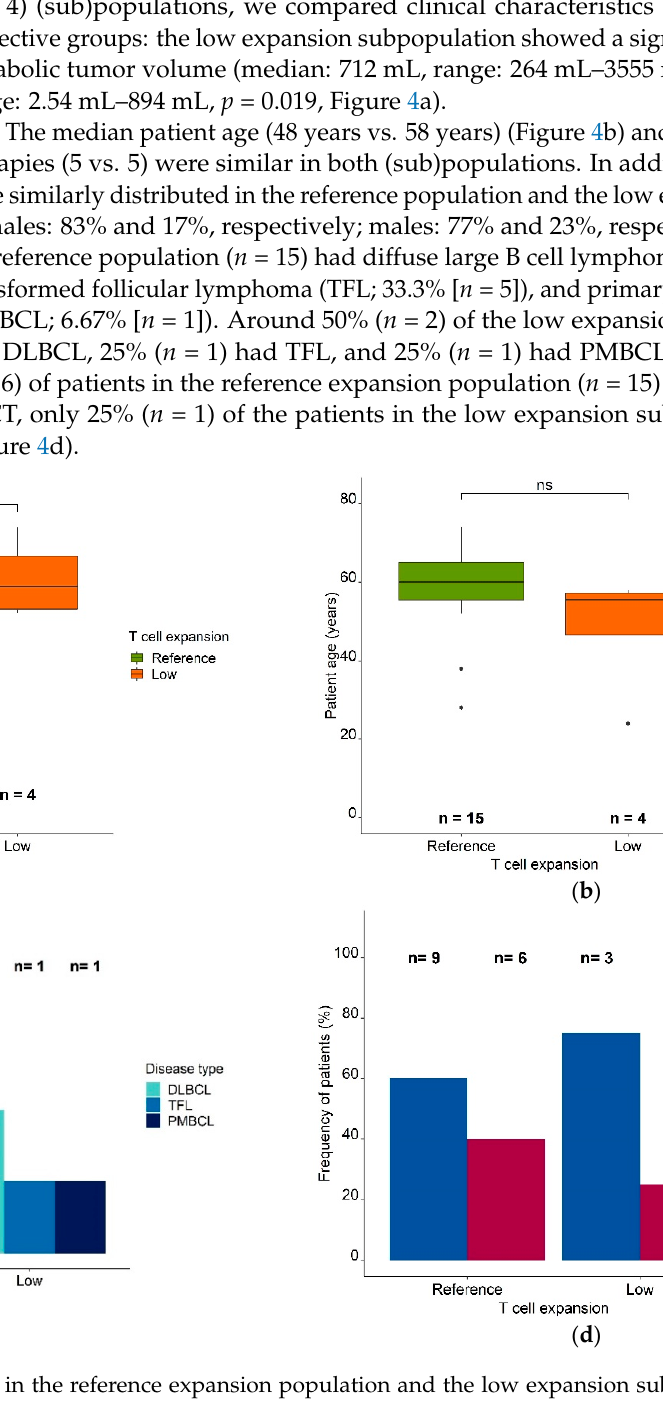
Figure 4. Patient characteristics in the reference expansion population and the low expansion subpopulation. Legend: Figure 4. ( a ) Baseline metabolic tumor volume (mL) in the reference expansion population and the low expansion subpopulation. ( b ) Patient age in the reference expansion population and the low expansion subpopulation. Boxes: interquartile range (IQR) including median; whiskers: range from hinge to lowest/highest value within 1.5 IQR; points: data outside whisker. ( c ) Frequency of patients in the reference expansion population and the low expansion subpopulation, stratified for disease type. ( d ) Frequency of patients in the reference expansion population and the low expansion subpopulation, stratified for a previous ASCT. Abbreviations—ASCT: autologous stem cell transplantation, DLBCL: diffuse large B cell lymphoma, PMBCL: primary mediastinal B cell lymphoma, TFL: transformed follicular lymphoma, *: p ≤ 0.05, ns: p >